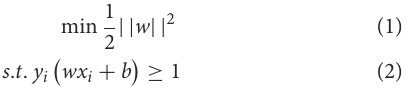
The sEMG data was filtered to remove noise and keep the useful information unchanged. The valid frequencies of the sEMG original signal mainly locate at 0–500Hz, and the frequency range of noise generated by power-line interference, electrode movement and motion artifacts are all below 20Hz. A fifth-order Butterworth bandpass filter (20–500Hz) was used to process the raw sEMG signal. Meanwhile, to extract the active EMG signal and eliminate the useless information in the rest states, the EMG data from the biceps and triceps channels were intercepted. In addition, the threshold value worked for eliminating inactive data in all channels of each participant. The threshold was set as 70%, and the data with the top 70% amplitude will be retained and the remaining data will be